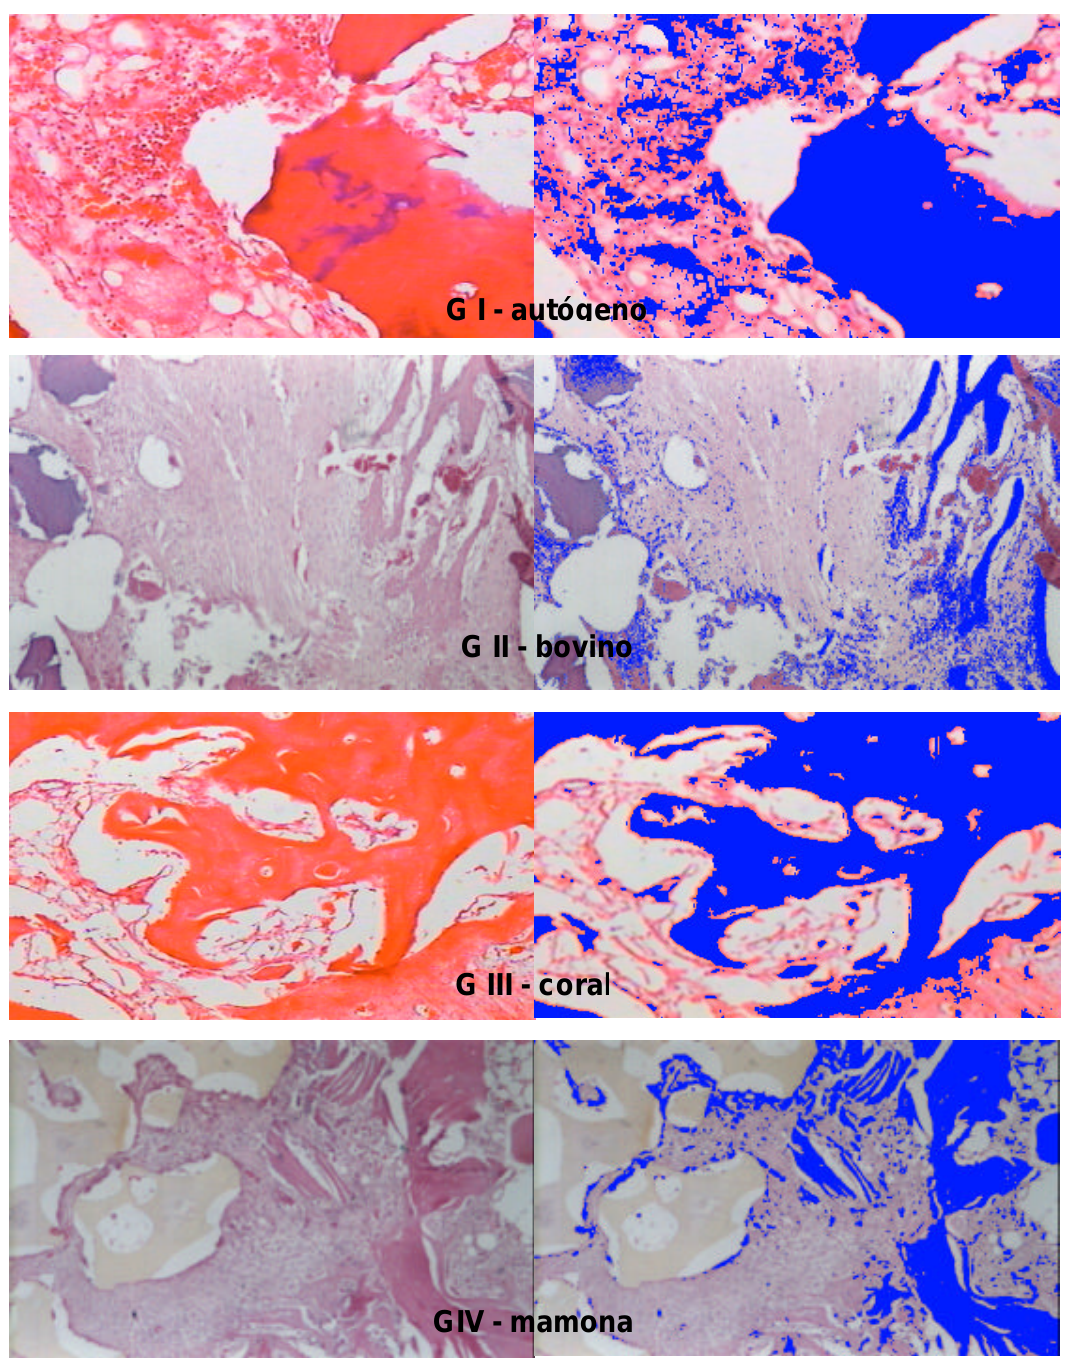
FIGURA 2 – Fotomicrografias mostrando a presença e quantificação do tecido ósseo neoformado (áreas em azul) em côndilos femorais, com seguimento de 4 semanas. HE